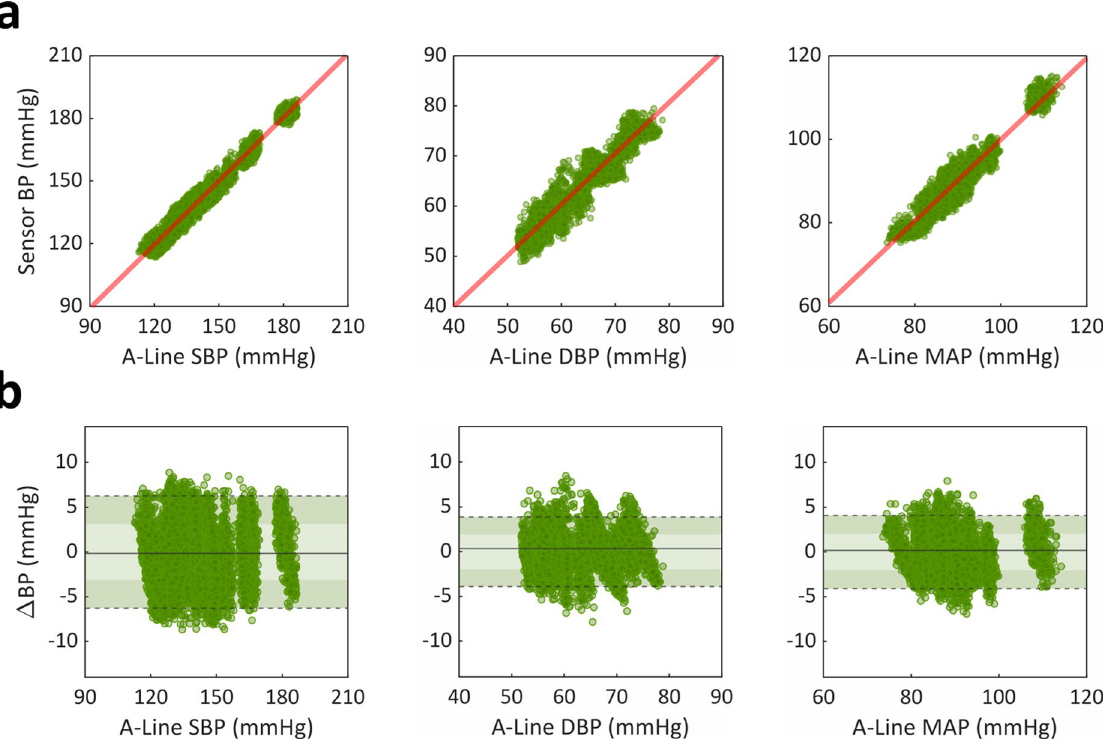
Figure 4. Assessing accuracy and precision of inpatient BP monitoring using a PPG sensor. ( a ) Pearson correlation and ( b ) Bland–Altman analyses compared beat-to-beat (left) SBP, (middle) DBP, and (right) MAP measurements between the noninvasive PPG sensor and invasive A-line. ( a ) PPG sensor measurements (n = 9628) showed strong linear correlations to the A-line, with Pearson coefficients of 0.982, 0.958, and 0.952 for SBP, DBP, and MAP, respectively. ( b ) PPG sensor measurements (n = 9628) demonstrated mean biases of − 0.14 (3.20), 0.36 (1.99), and 0.19 (2.09) mmHg for SBP, DBP, and MAP, respectively. Light- and dark-shaded areas represent 68% (1 SD) and 95% (1.96 SD) limits of agreement, respectively.